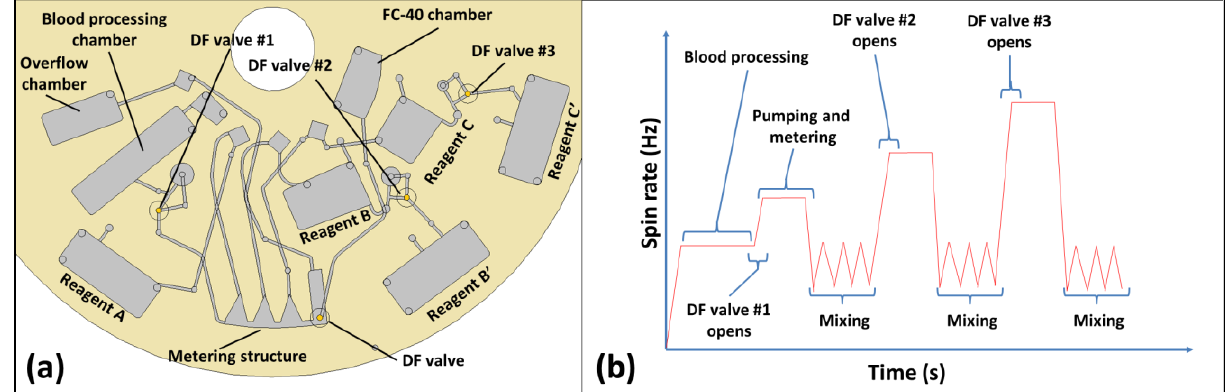
Figure 7. ( a ) Schematic of multi-parameter disc with the optimised spatial distribution of chambers. Note that the crossing channels are enabled by the multilayer architecture. ( b ) The operational spin protocols. The spin rates used are defined in the article text.